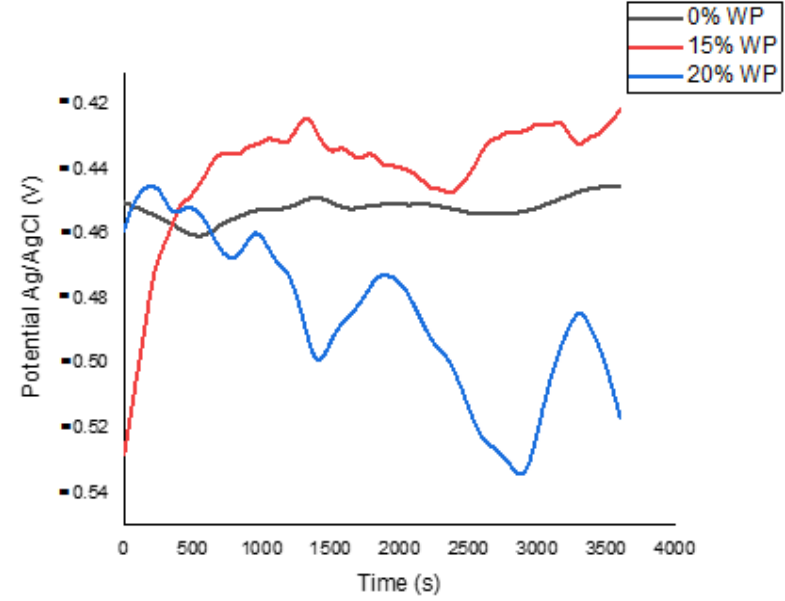
Figure 3. Open circuit potential (OCP) plot of the composite.